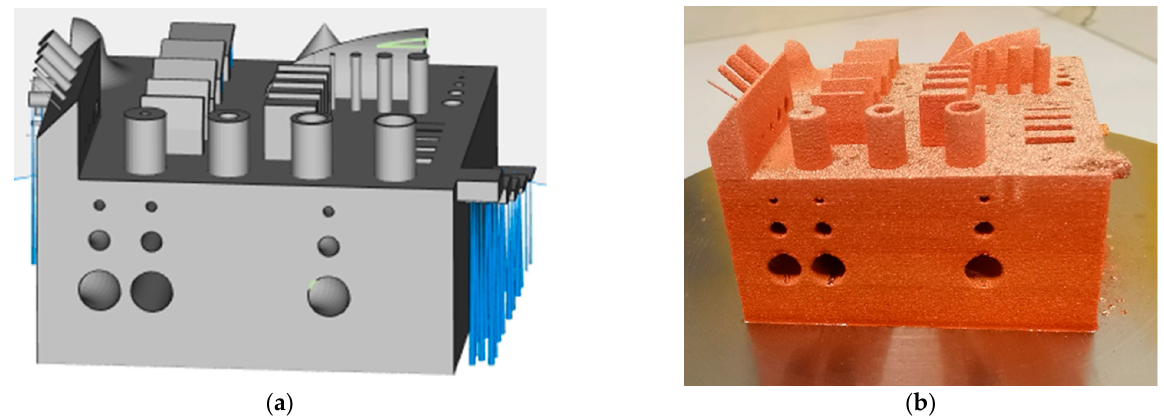
Figure 2. Benchmark geometry ( a ) build job preparation file with support structures (blue) and ( b ) pure copper structure built with Cu-OFHC.